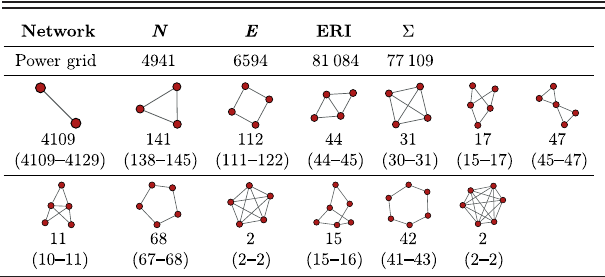
TABLE I. The network motifs of the network representing the Western States Power Grid of the United States found using connected subgraphs up to size 6. The ranges of the motif counts of the covers found over ten runs are also shown in